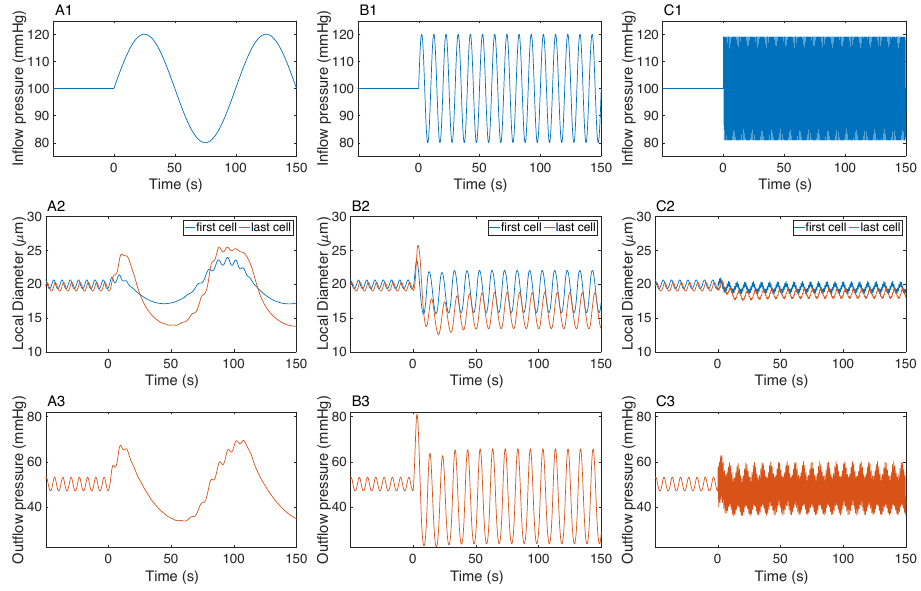
Figure 10. ( 1 ) Inflow pressure; and predicted oscillations in ( 2 ) local diameter for the first and last cells in the afferent arteriole; and ( 3 ) outflow pressure when a sinusoidal perturbation is applied to the inflow pressure with amplitude A = 20 mmHg and frequency ( A ) 0.01 Hz; ( B ) 0.1 Hz; and ( C ) 1